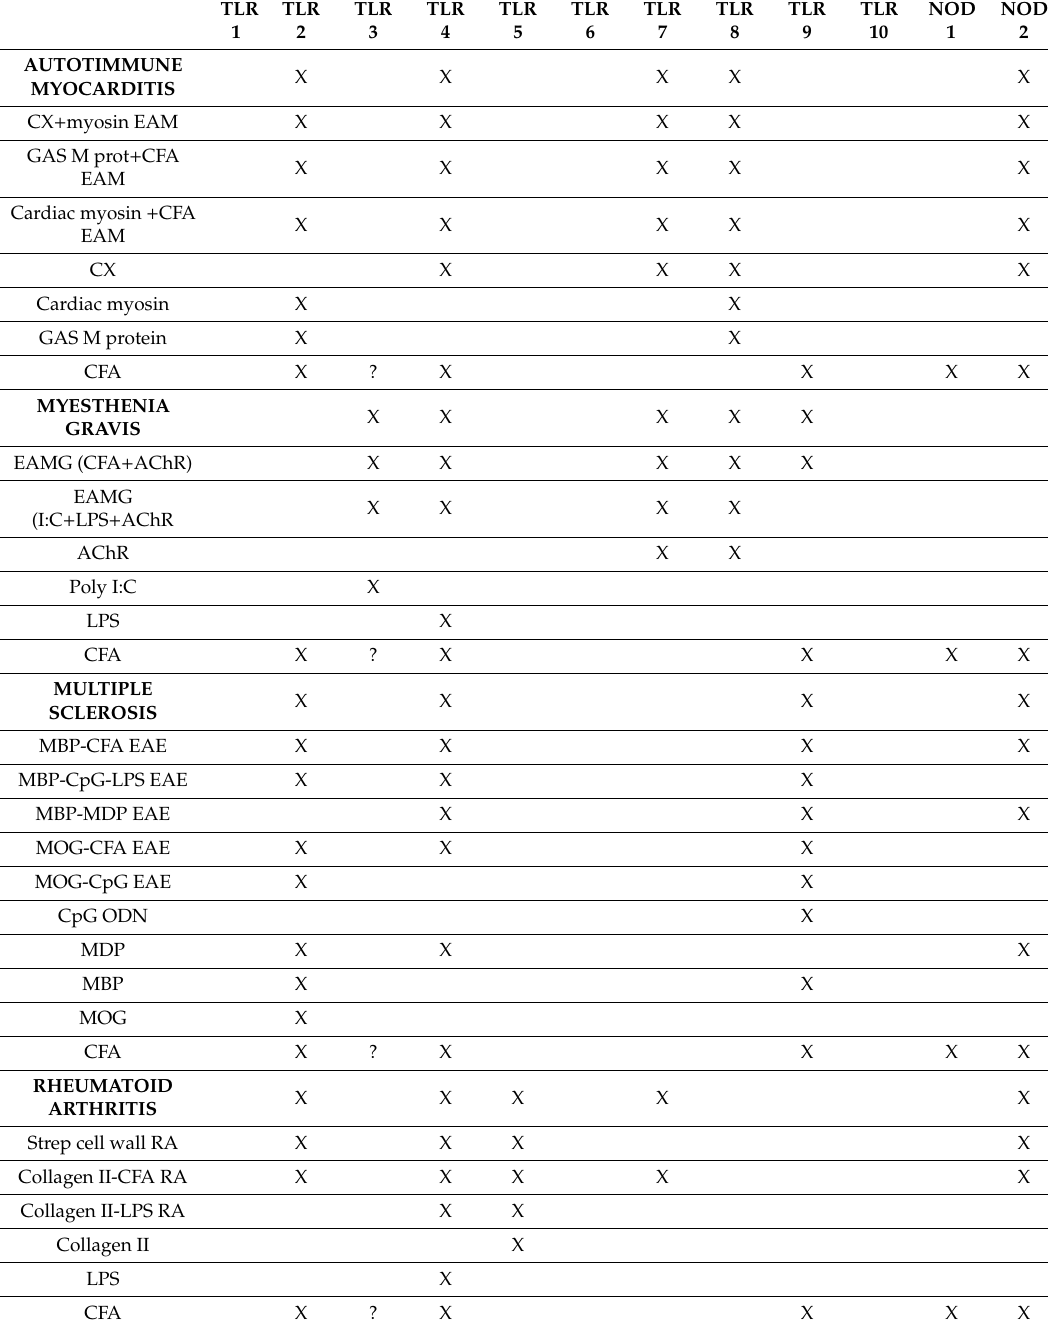
Table1. Summaryoftoll-likereceptor(TLR)andnucleotide-bindingoligomerizationdomain-containing proteins (NOD) activation (X) in autoimmune myocarditis (AM), myasthenia gravis (MG), multiple sclerosis (MS) and rheumatoid arthritis (RA) and their most common animal models experimental AM (EAM), experimental autoimmune MG (EAMG), experimental allergic encephalomyelitis (EAE) for MS and experimental RA (see text for details and references). Most of the models are implemented in mice, but some are in rats or guinea pigs either instead or in addition. CX—coxsackievirus;